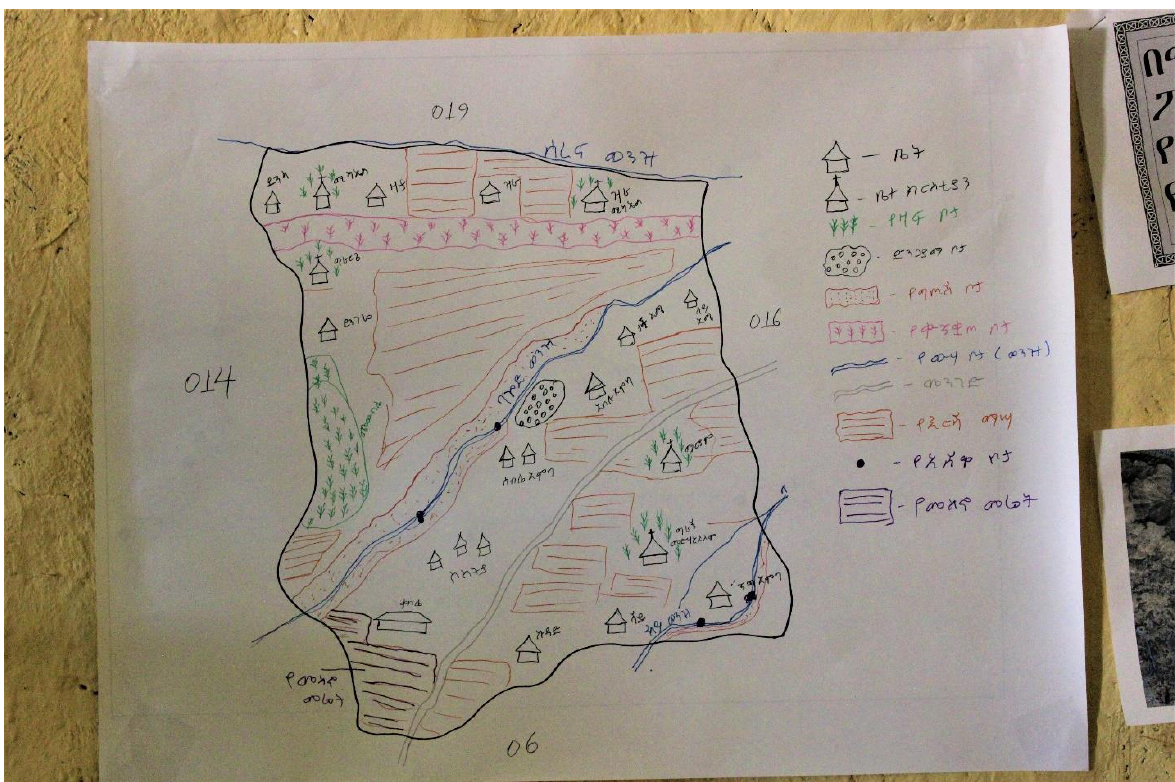
Fig. A1.1. Participatory map drawn by residents of kebele 15